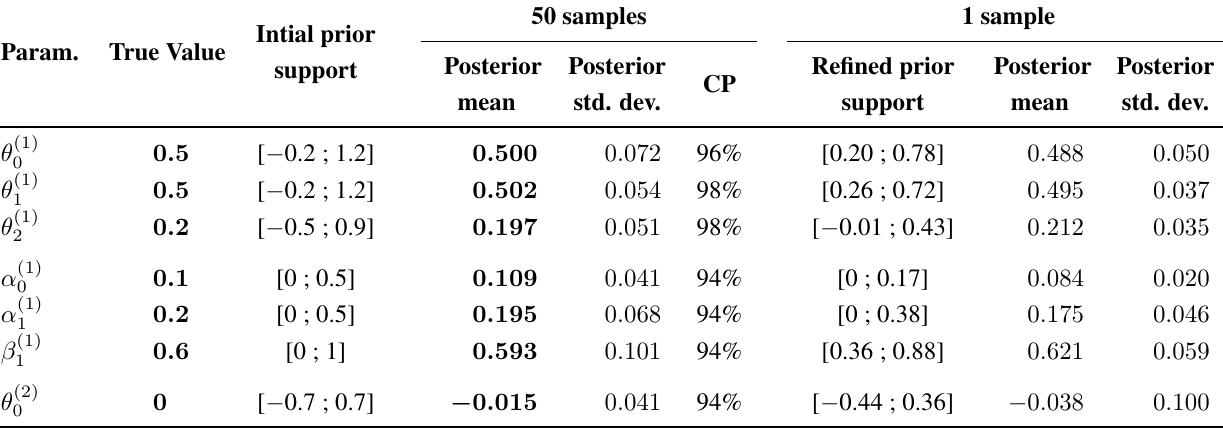
Table 1. Statistics on the posterior estimates for a synthetic MS(2)-AR(2)-GARCH(1,1) process, for 1 and 50 samples: Posterior means, standard deviations and coverage probabilities